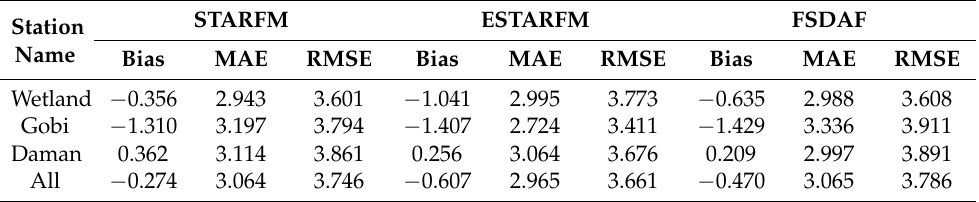
Table 3. The bias (K), MAE (K), and RMSE (K) of fused LST over stations.